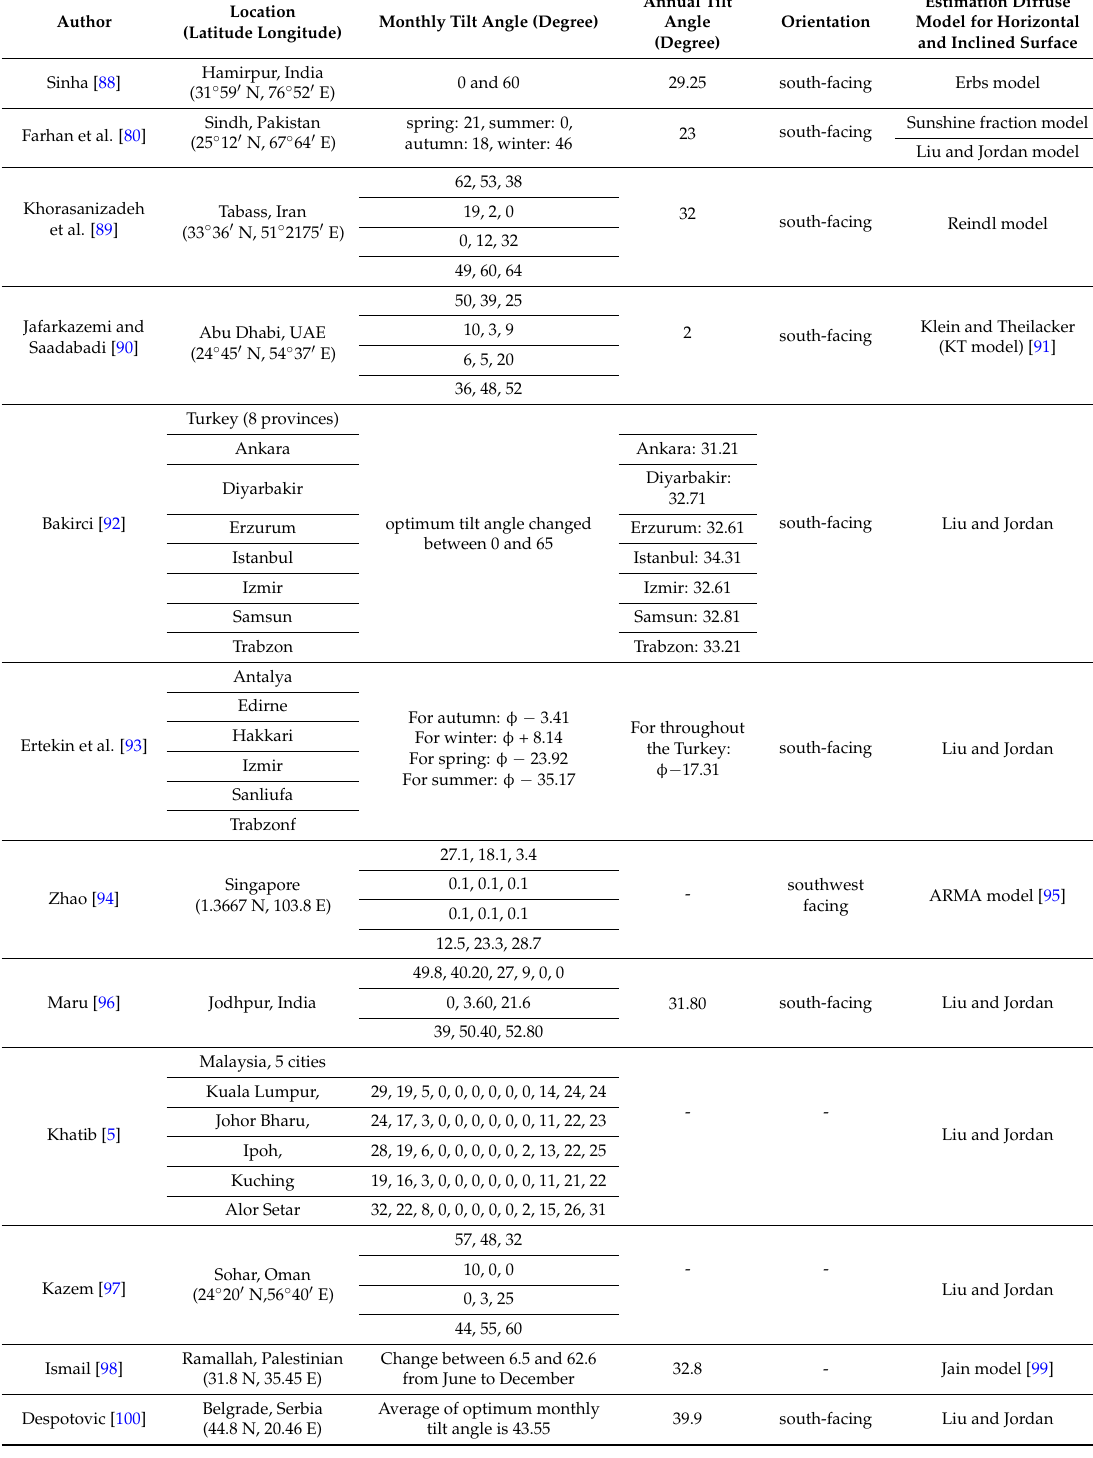
Table 10. Optimum tilt angle for different